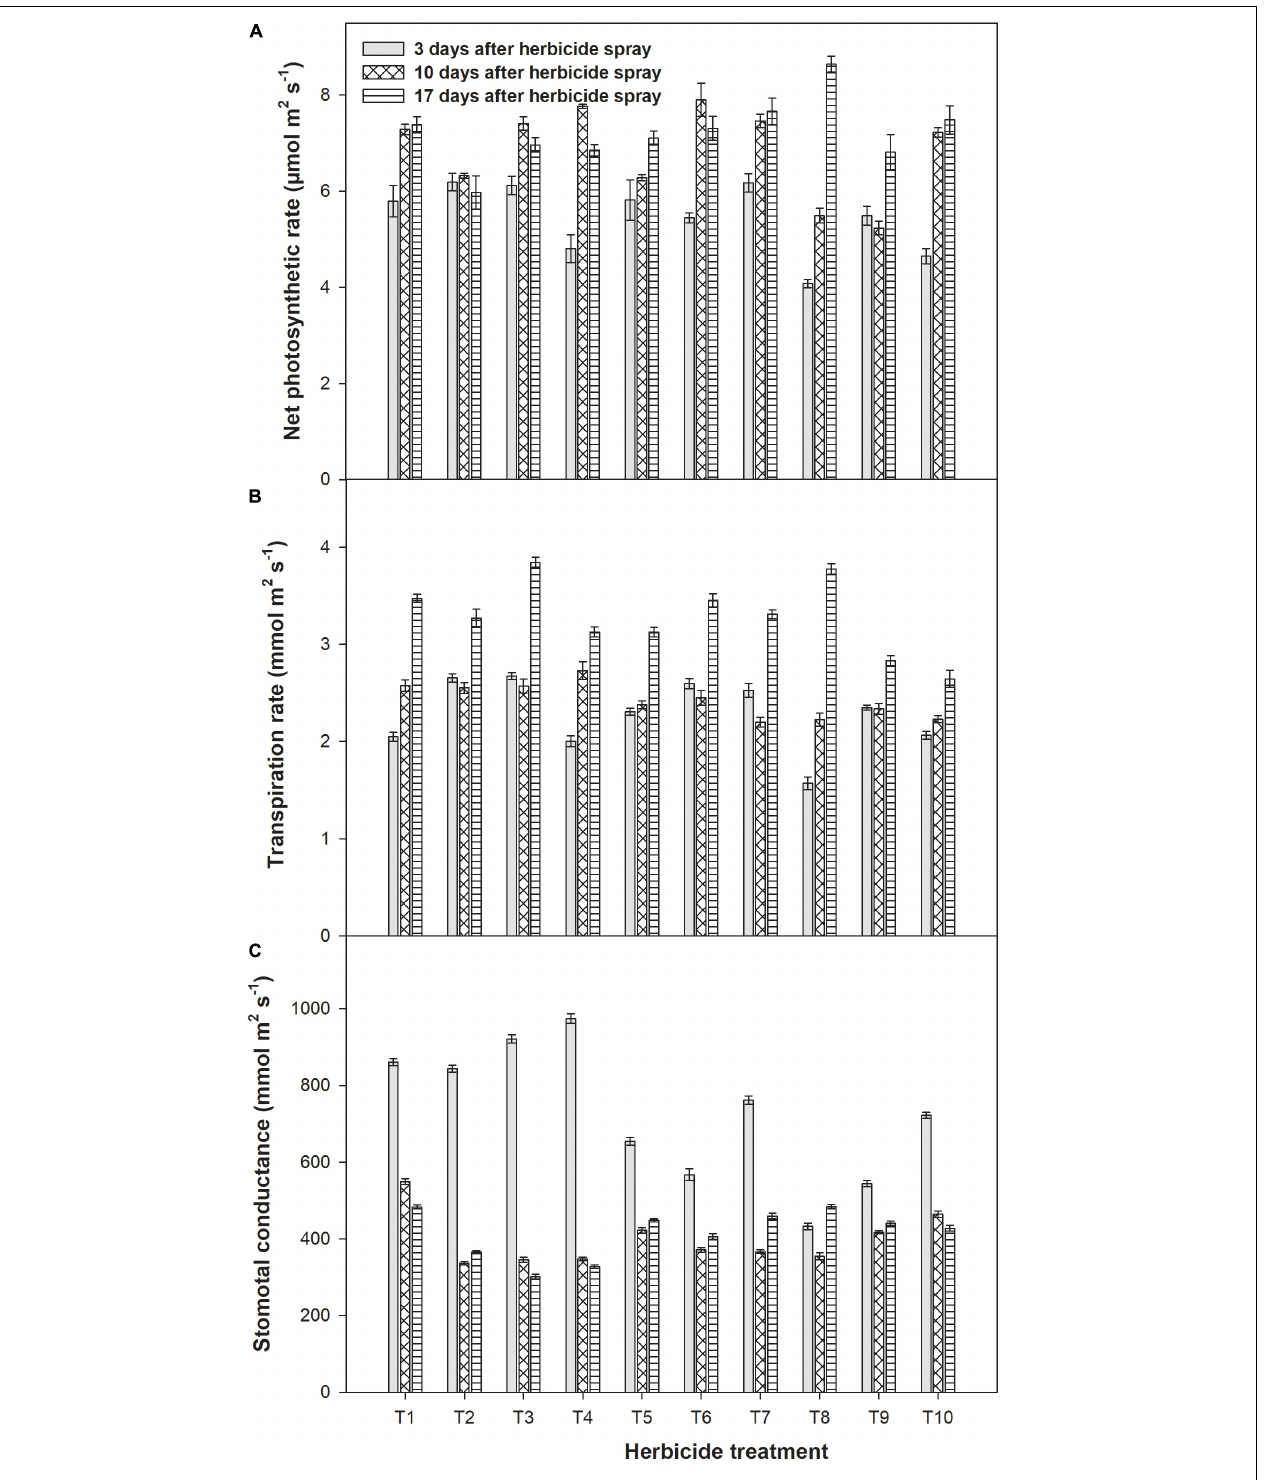
FIGURE 1 | Impact of metribuzin with and without adjuvants on net photosynthetic rate (A) , transpiration rate (B) , and stomatal conductance (C) of wheat at 3, 10, and 17 days after herbicide spray (average of 2 years’ data). T 1 , weedy check; T 2 , metribuzin at 175 g a.i. ha − 1 ; T 3 , metribuzin at 140 g a.i. ha − 1 ; T 4 , metribuzin at 105 g a.i. ha − 1 ; T 5 , metribuzin at 175 g a.i. ha − 1 + Ad-500 at 400 ml ha − 1 ; T 6 , metribuzin at 140 g a.i. ha − 1 + Ad-500 at 400 ml ha − 1 ; T 7 , metribuzin at 105 g a.i. ha − 1 + Ad-500 at 400 ml ha − 1 ; T 8 , metribuzin at 175 g a.i. ha − 1 + Bio-power at 400 ml ha − 1 ; T 9 , metribuzin at 140 g a.i. ha − 1 + Bio-power at 400 ml ha − 1 ; T 10 , metribuzin at 105 g a.i. ha − 1 + Bio-power at 400 ml ha − 1 .